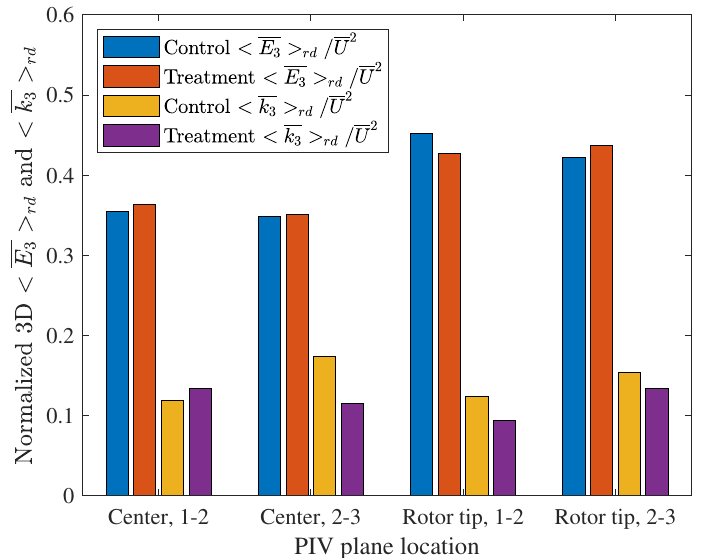
Figure 14. Comparisons between control and treatment of the spatially and temporally averaged mean and turbulent kinetic energies at each PIV measurement location. Note that these have been calculated using the axisymmetric